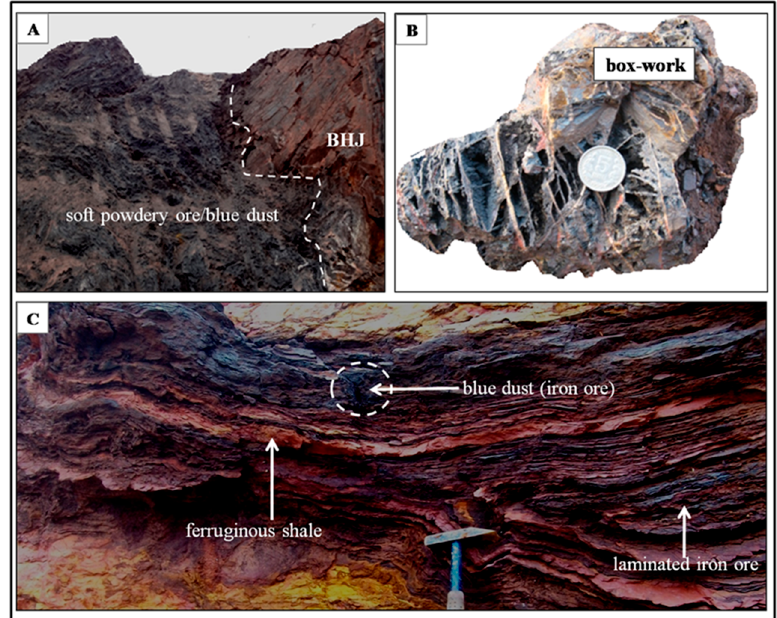
Figure 13. ( A ) Field photograph showing formation of high-grade iron ores (blue dust) from BHJ through leaching processes; ( B ) box-work structure developed in goethitic ore formed due to erosional cycle, indicating paleoclimatic controls on the genesis of high-grade iron ores at KMIOD; and ( C ) inter-bedded ferruginous shale associated with BIFs which leads to the formation of blue dust through continuous leaching processes.